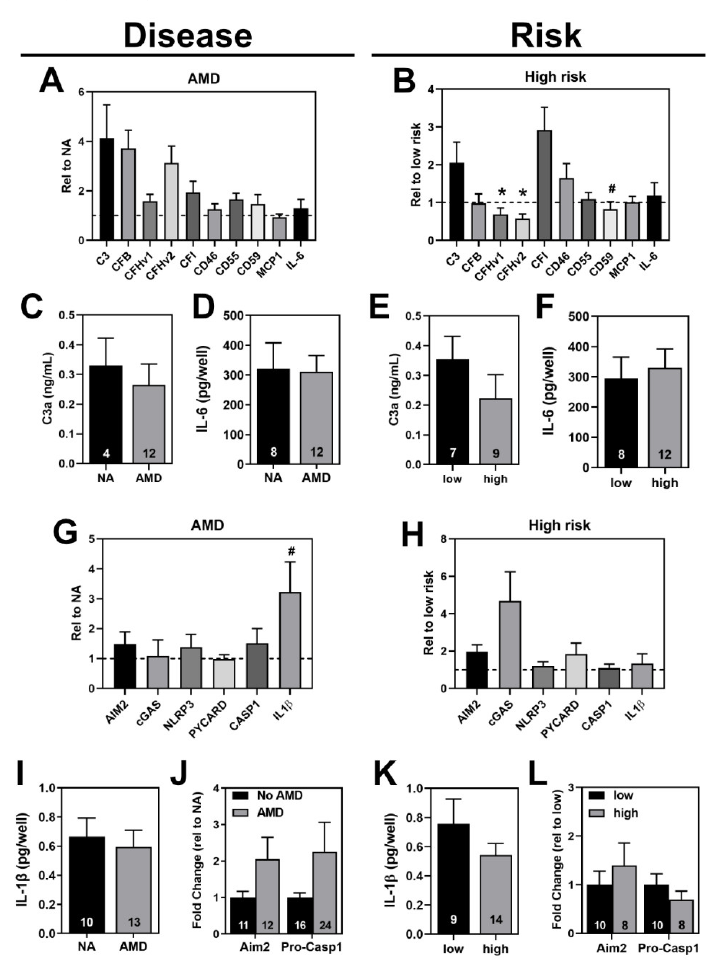
Figure 3. Basal levels of complement and inflammasome in haRPE cells. ( A , B ) Gene expression analysis of complement-related genes in haRPE from ( A ) No AMD ( n = 17) and AMD ( n = 22) donors or ( B ) CFH low-risk ( n = 15) and high-risk ( n = 21) donors. Results shown are fold-change in expression of ( A ) AMD relative to the average of No AMD samples (dashed line) or ( B ) high-risk relative to the average of low-risk donors (dashed line). ELISA for C3a ( C , E ) and IL-6 ( D , F ) in media from haRPE comparing No AMD and AMD or low-risk and high-risk. ( G , H ) Gene expression analysis of inflammasome-related genes in haRPE from ( G ) No AMD ( n = 6) and AMD ( n = 6) donors or ( H ) CFH low-risk ( n = 5) and high-risk ( n = 7) donors. Results shown are fold-change in expression of ( G ) AMD relative to the average of No AMD samples (dashed line) or ( H ) high-risk relative to the average of low-risk donors (dashed line). ELISA for IL-1 β ( I , K ) in media from haRPE comparing No AMD and AMD or low-risk and high-risk. ( J , L ) Content analysis of inflammasome proteins in ( J ) No AMD and AMD cells or ( L ) low-risk and high-risk cells. Data shown are mean ± SEM. # p < 0.1, * p < 0.05 determined by unpaired t test. Numbers within the bars indicate number of individual donors used in the